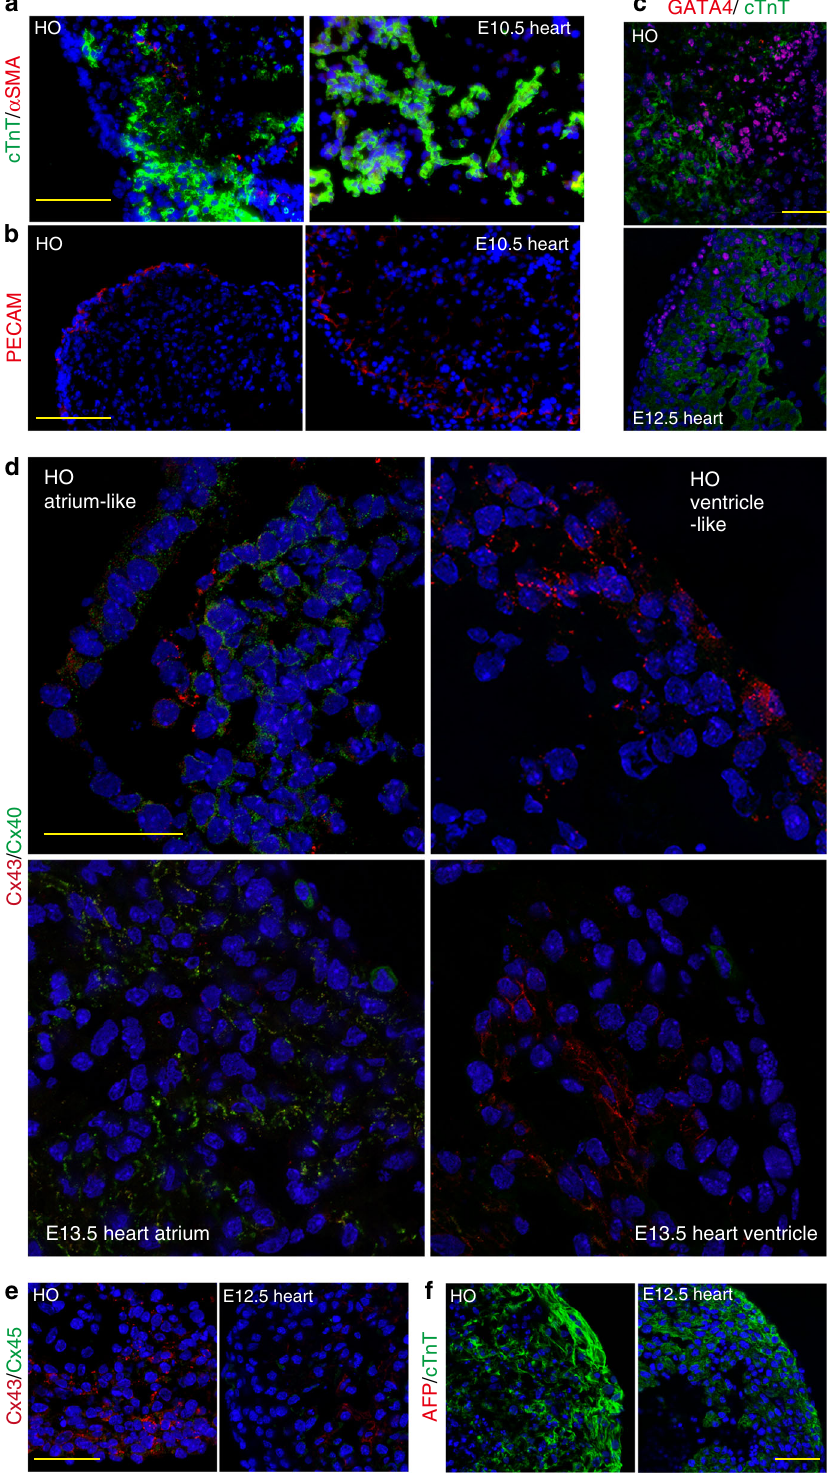
Fig. 5 Evaluation of the cell components of heart organoid (HO)s. a Immuno fl uorescent staining to detect cTnT (a CM marker, green)/ α SMA (an SM marker, red) and b PECAM (an EC marker, red) in the HO and E10.5 heart cryosections. Expression of cTnT and α SMA was observed in the HOs ( n = 7 out of n = 9, two experiments). Also, segregated lining expression of PECAM (red) was detected in the HOs (over n = 9, two experiments). Scale bar: 100 μ m. c – f Immunostaining to detect c GATA4 (red)/cTnT (green), d Cx43 (red)/Cx40 (green), e Cx43 (red)/Cx45 (green), and f AFP (red)/cTnT (green). Scale bar: 50 μ m. c Expression of GATA4, a cardiac TF, was observed in both HOs ( n = 8 out of n = 9, two experiments) and E12.5 heart. d Expression of Cx40 in atrium-like region detected in the HOs ( n = 7 out of n = 13, two experiments) was similar to that of atrium in E13.5 heart. e The organized distribution of two types of Connexin (Cx43 and Cx45) in the HOs (over n = 8, two experiments) was similar to that of E12.5 heart (the ventricle part), although a small number of Cx45 (green)-positive cells was observed. f No expression of AFP (a liver marker) was detected in both HOs ( n = 8, over two biologically independent experiments) and E12.5